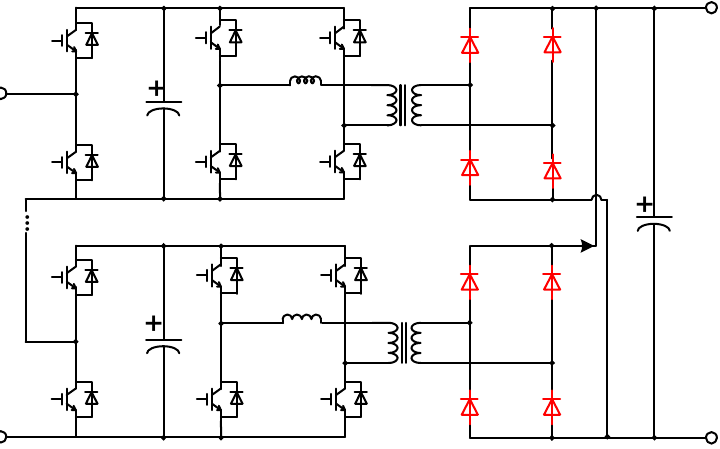
Figure 10. DCT for the pure PV accesses scenario.